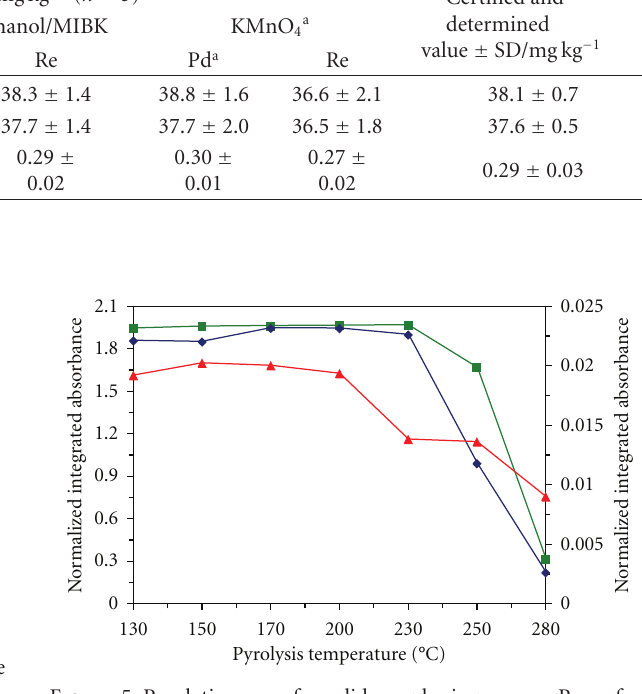
with Pd modifier and 1.9-2.0% for 10–15 ng Hg ( n = 5) with